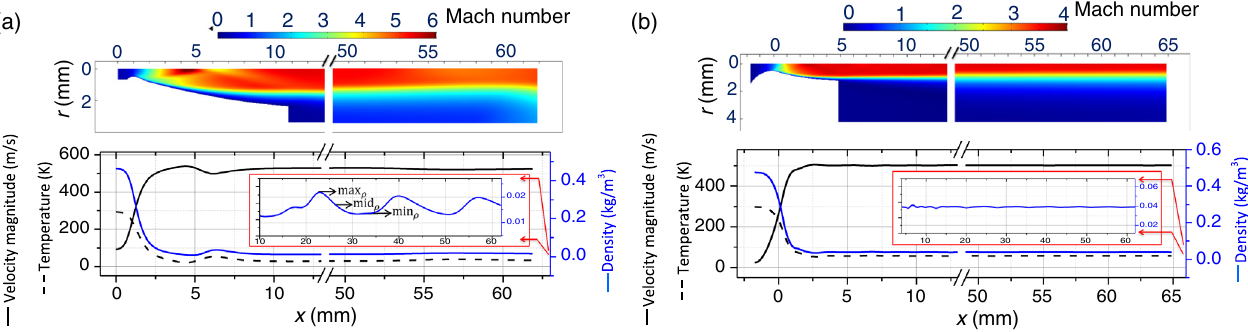
¼ 1 . 13 mbar, the nozzle exit is at x bg